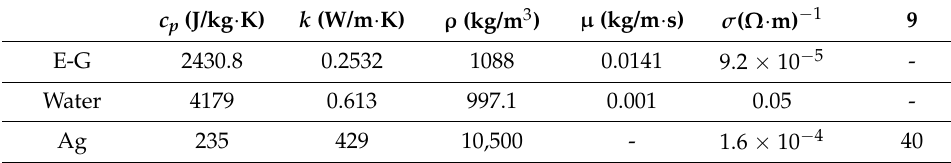
Table A1. Thermophysical properties of water/E–G and Ag [18,47,49–53].